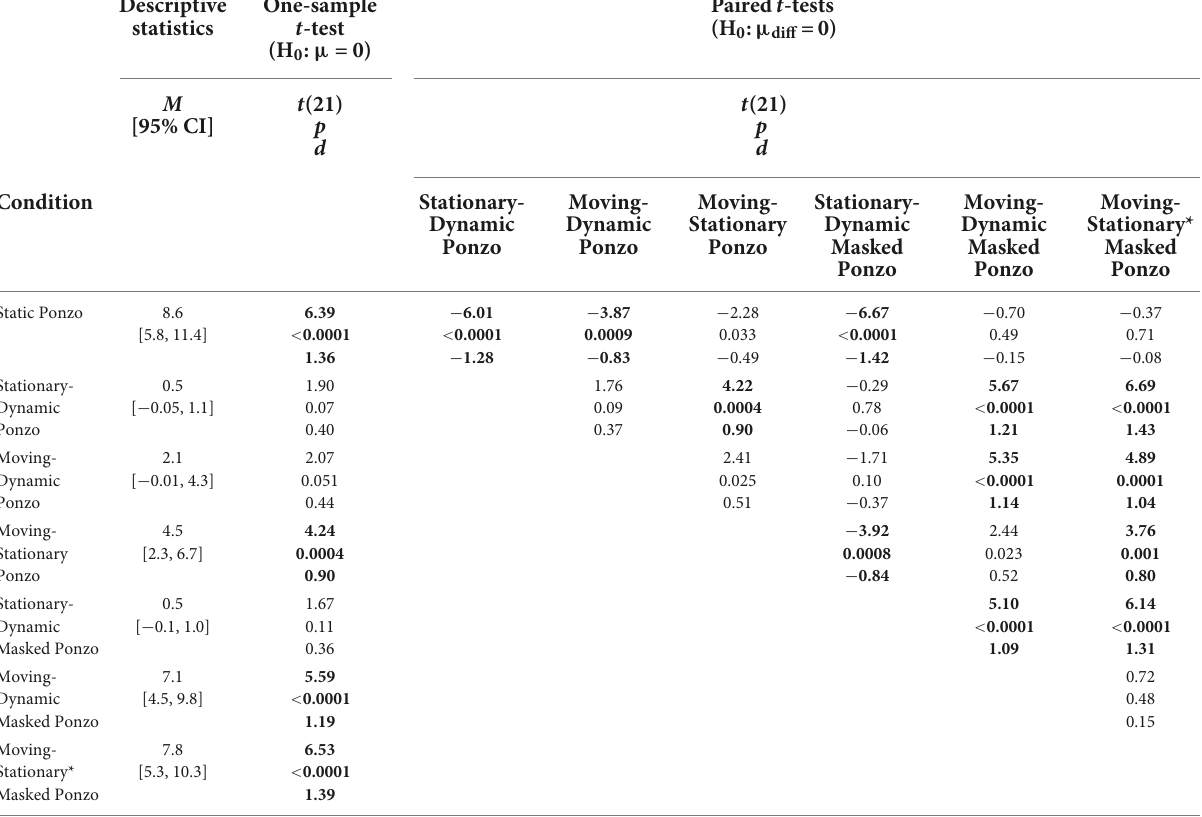
TABLE 3 One-sample and pairwise paired t -tests for all conditions with surrounding context of Experiment 3. Descriptive